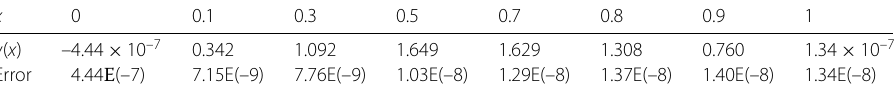
Table 5 For Example 6, showing the numerical solutions and the absolute errors obtained by the BSFM at different